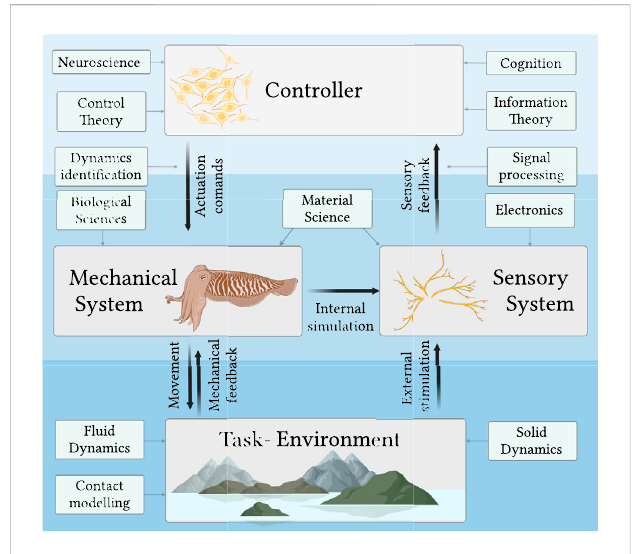
FIGURE 1 A schematicrepresentation of the disciplines involved in the design of soft robots with embodied intelligence, i.e., systems in which the intelligence spans between Brain, Body and environmental interaction.